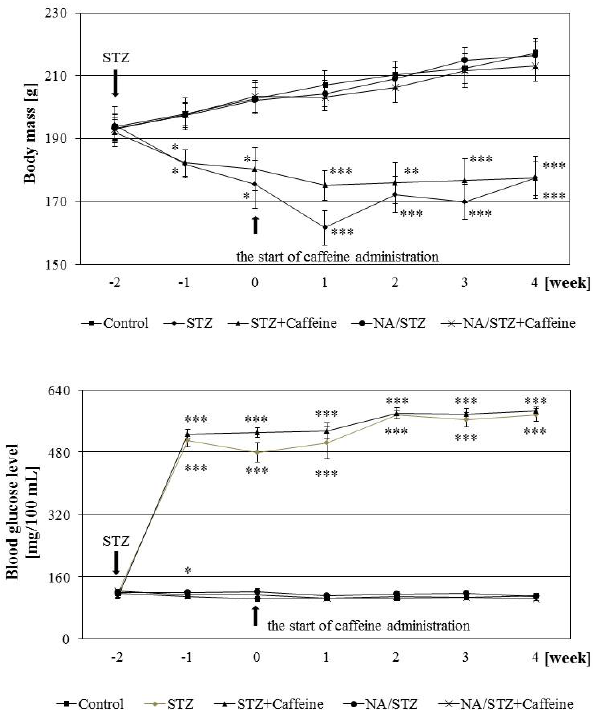
Figure 1. Effect of caffeine administered orally (20 mg/kg daily for four weeks) on the body mass and non-fasting blood glucose concentration in rats treated with streptozotocin (STZ) or nicotinamide and streptozotocin (NA/STZ). Results are presented as means ± SEM (standard error of the mean; n = 8–10). The final measurements of the body mass and blood glucose concentration were made before the last caffeine/vehicle administration. Kruskal–Wallis ANOVA followed by Mann–Whitney U test were used the control